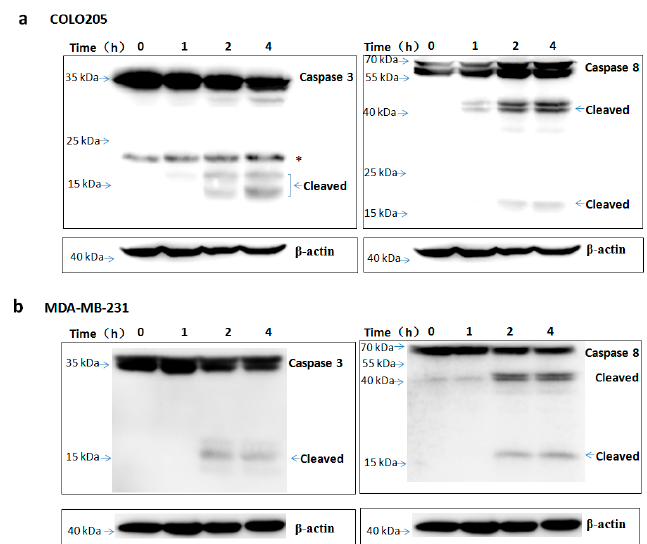
Figure 8. TR2-3 activation of caspase-3 and caspase-8 in COLO205 and MDA-MB-231 cells. The ( a ) COLO205 and ( b ) MDA-MB-231 cells were incubated with TR2-3 for indicated time periods and the whole cell lysates were immunoblotted with the indicated antibodies. * indicates cross-reacting proteins. These data are representative of at least three independent experiments.